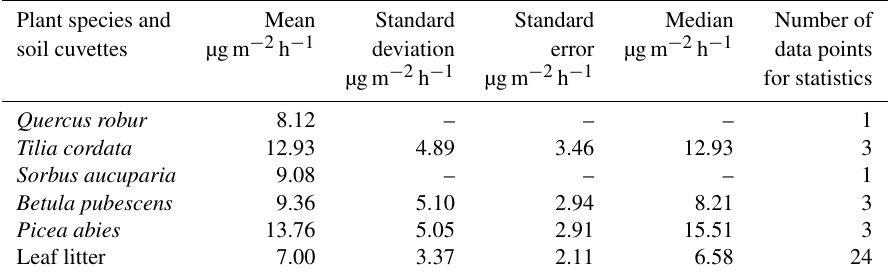
Table 2. Emission rates of MEK for typical hemiboreal plant species and soil litter measured by GC-MS technique at the SMEAR site. Plant species and Mean Standard